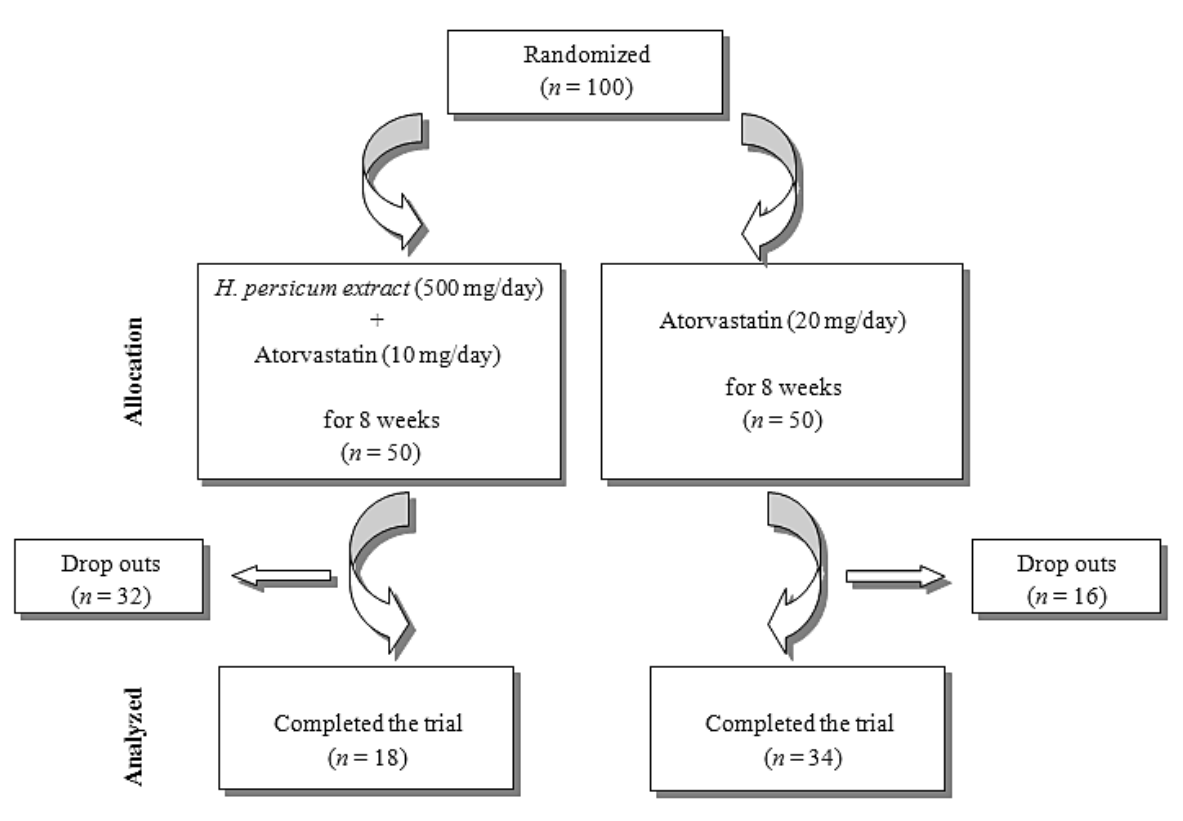
FIGURE 1. Flowchart of the